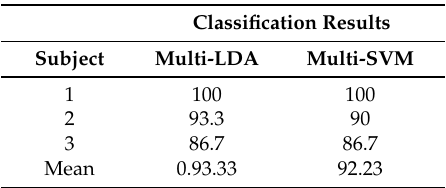
Table 8. Classification accuracy results with multi-LDA and multi-SVM.